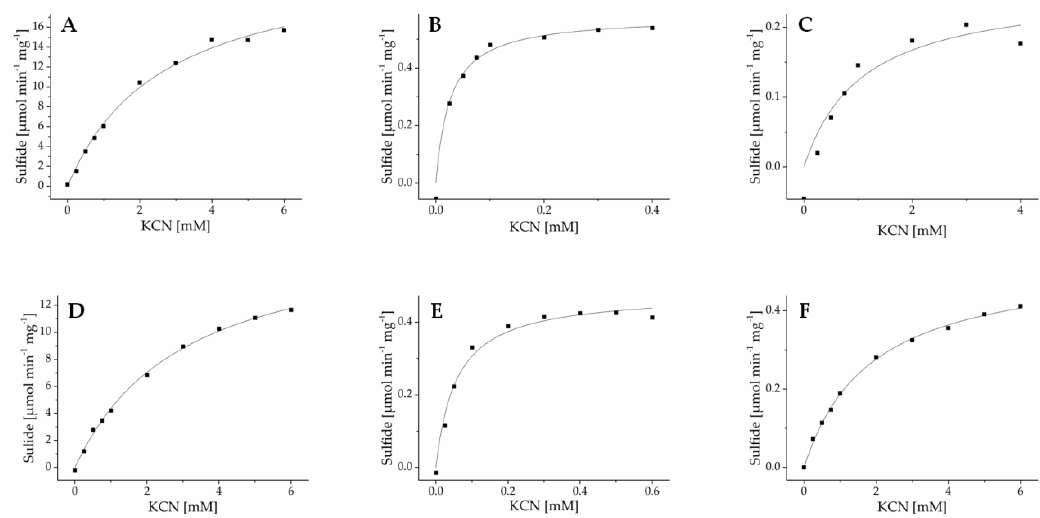
Figure 6. Kinetics of β-cyanoalanine synthases from Pierinae. AcaBSAS1 ( A ), AcaBSAS2 ( B ) and AcaBSAS3 ( C ) from A. cardamines and AcrBSAS1 ( D ), AcrBSAS2 ( E ) and AcrBSAS3 ( F ) from A. crataegi were incubated with 6 mM cysteine and varying cyanide concentrations in the presence of pyridoxal-5 (cid:48) -phosphate and sulfide formation determined colorimetrically. Shown are the results of one out of three independent experiments. Each data point represents the mean of three technical replicates. The curves were generated by nonlinear fitting to the Michaelis-Menten equation. The kinetics of BSAS from other species are shown in Figure S3. Table 2. Kinetic constants of the characterized β -cyanoalanine synthases. After incubation of the purified recombinant proteins with cysteine and cyanide in the presence of pyridoxal-5 (cid:48) -phosphate for 10 min, sulfide was quantified colorimetrically. Cyanide was used at 6 mM when cysteine concentrations were varied and cysteine was used at 6 mM when cyanide concentrations were varied. Given are the means ± SEM from n = 3 independent expression experiments. Pd, Pieridae; Pn, Pierinae; C, Coliadinae; Z, Zygaenidae; N, Noctuidae; P, Plutellidae; Data for PrBSAS1-PrBSAS3 [13] are listed for comparison.